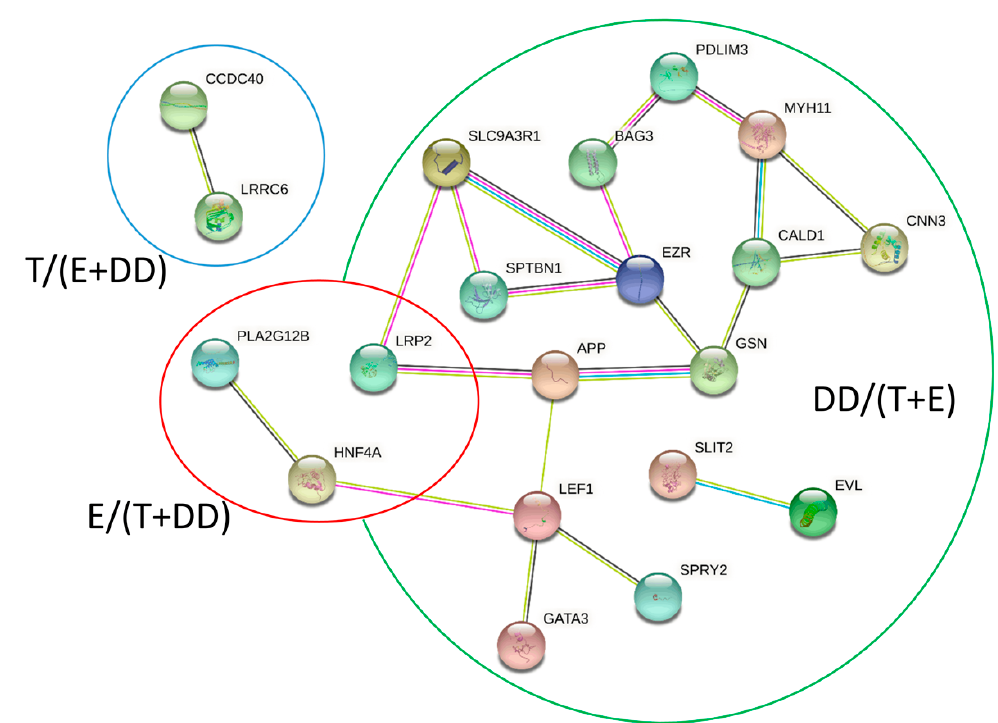
Figure 7. The STRING network of proteins involved in sperm motility. DD/(T + E), E/(T + DD) and T/(E + DD) groups correspond to the three groups of analyzed processes (see Table 4 and Figure 5). The color of the lines symbolizes the type of interaction and the source of information: light blue and pink-known interactions, green, red and blue-predicted interactions, yellow—text mining, black—co-expression, and purple—protein homology.